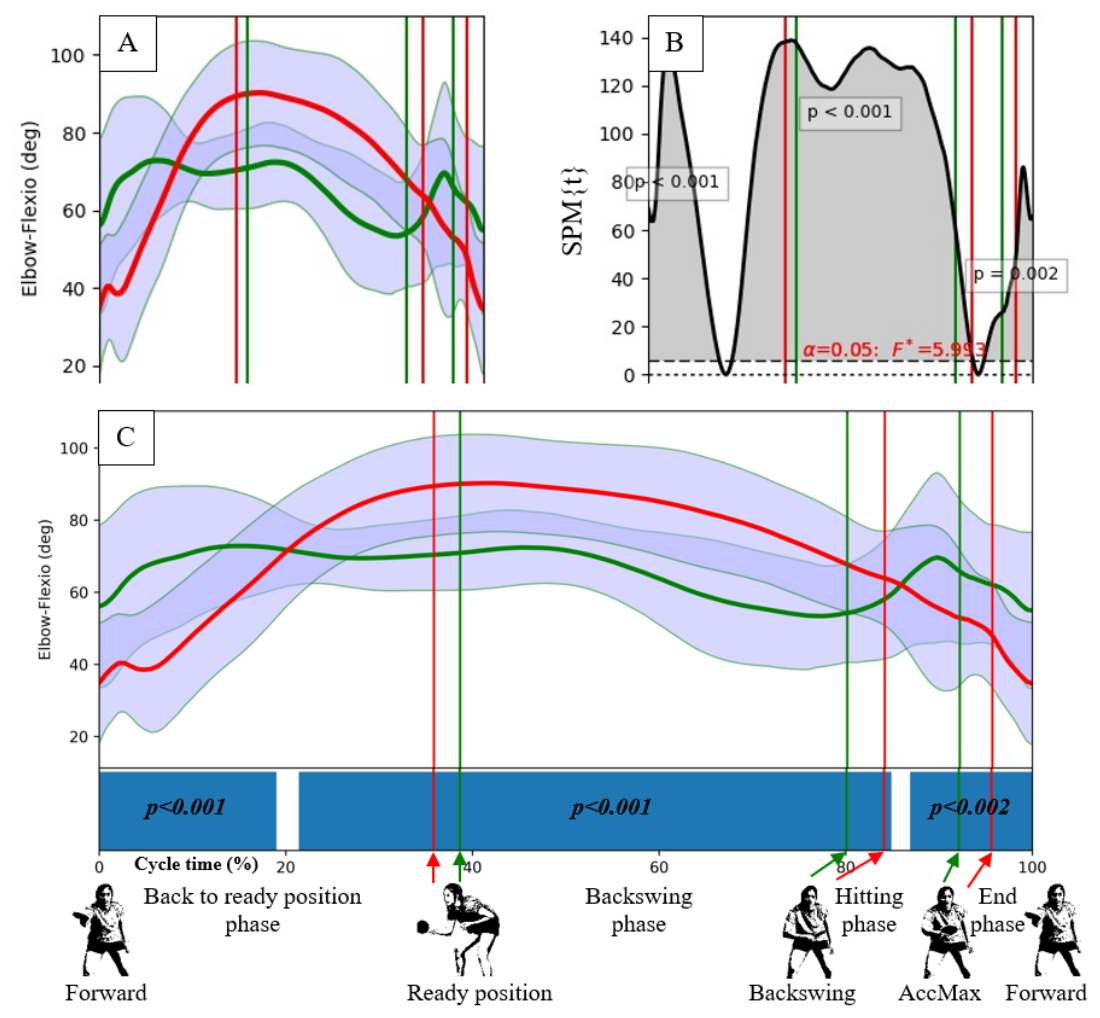
Figure 3. The statistical parametric mapping (SPM) procedure. For each data set ( A ) sampled every 0.1% of cycle time, an SPM{t} function ( B ) was calculated using Python. The SPM statistical information was transformed into a horizontal bar representation ( C ), designating the most significant differences between the compared patterns. The green curve presents the data for men, whereas the red one for women. The vertical lines represent the successive movement positions for men (green) or women (red) described with still images at the bottom.